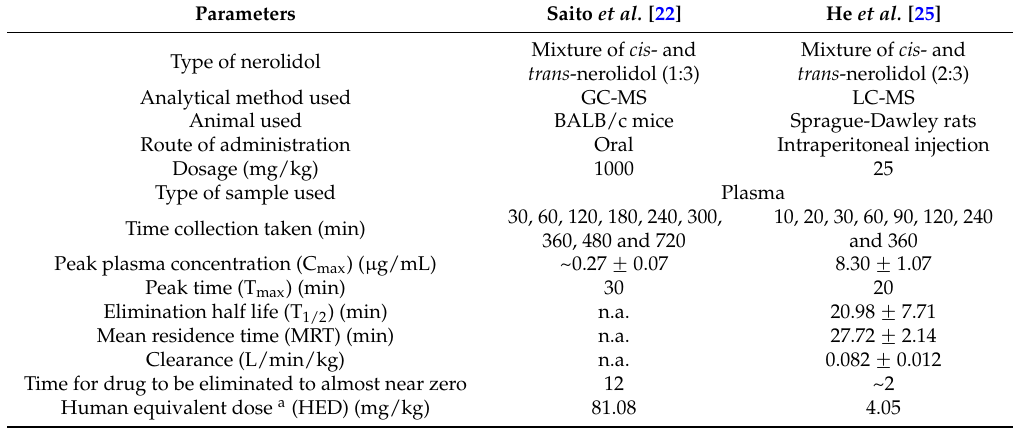
Table 5. Comparison of pharmacokinetic studies of nerolidol conducted by Saito et al. and He et al.